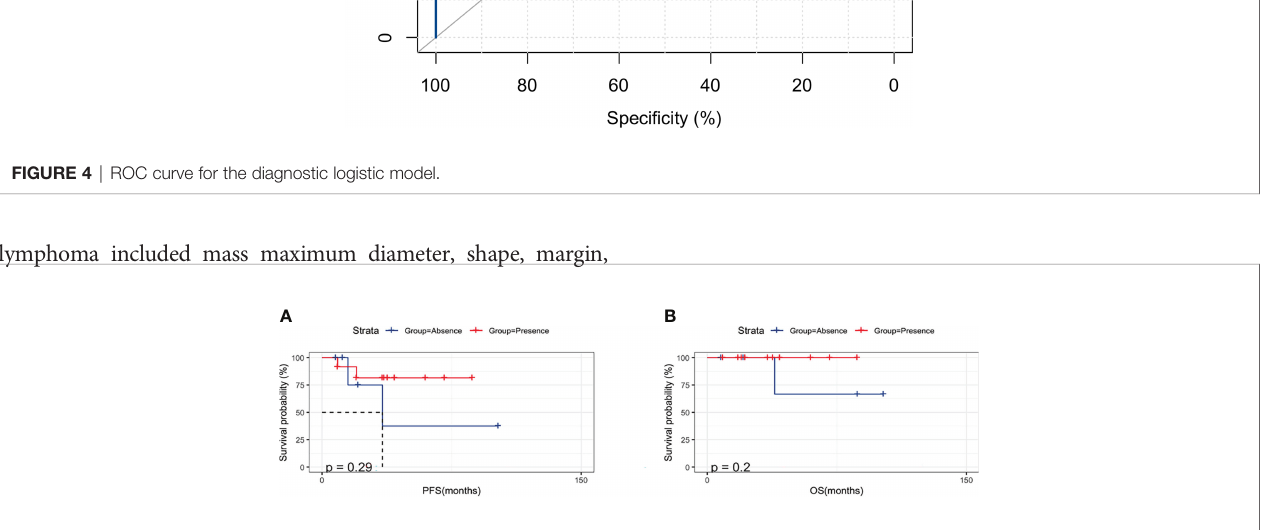
FIGURE 5 | Prognostic in fl uence of operation on primary breast